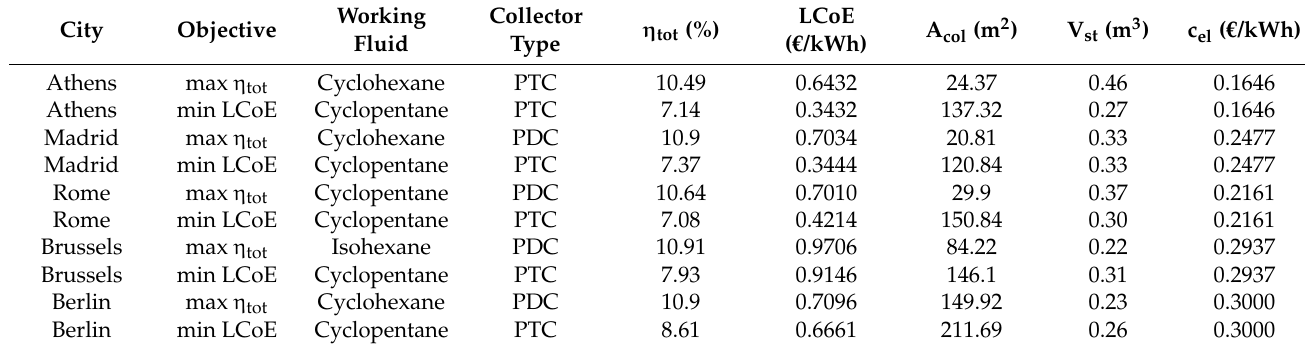
Table 11. Optimal working fluids, collector types, solar field areas and storage tank volumes that maximize total solar conversion efficiency and minimize levelized cost of electricity in each of the examined